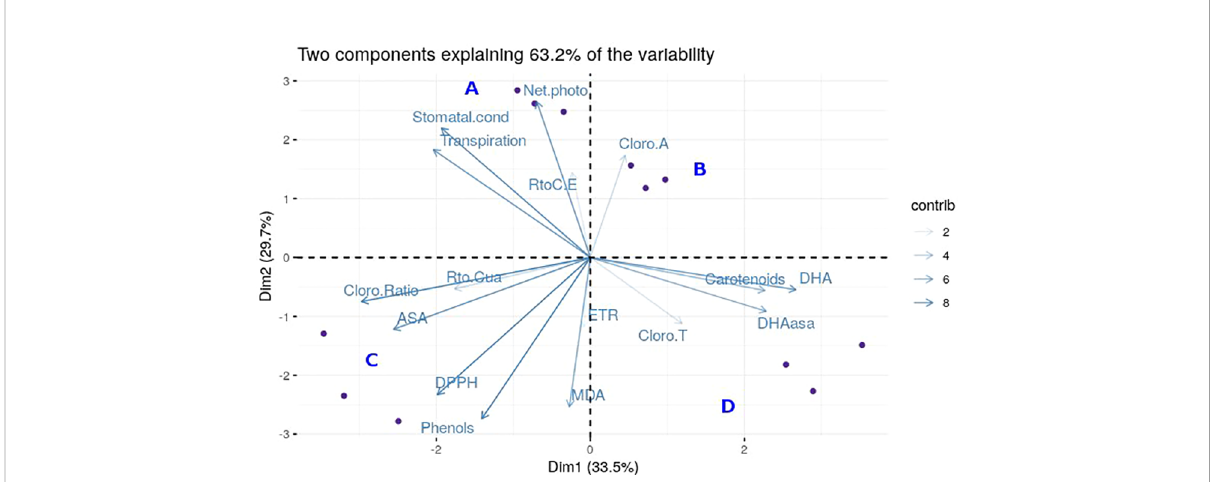
FIGURE 5 Graphical representation of Principal Components Analysis. For the PCA analysis, blue dots represent each individual. The different genotypes with the two different treatments are shown in each cuadrant: Resistant Non-Inoculated (A) , Resistant Inoculated (B) , Susceptible Inoculated (C) , and Susceptible Non-Inoculated (D) . Each blue arrow represents the vector of each variable with the following names: “ Cloro. Ratio ” for Chl- a/ b , “ Transpiration ” , “ Stomatal.cond ” for stomatal conductance, “ RtoC.E ” for effective quantum yield, “ Net.photo ” for net photosynthesis, “ Cloro.A ” for Chl- a , “ Carotenoids ” , “ DHA ” , “ DHAasa ” for DHA.AsA, “ CloroT ” for total chlorophylls, “ MDA ” for lipid peroxidation, “ ETR ” for electron transport rate, “ Phenols ” , “ DPPH ” for antioxidants, “ ASA ” , and “ Rto.Cua ” for maximum quantum yield. The transparency of the vectors is related to the contribution (contrib) of each